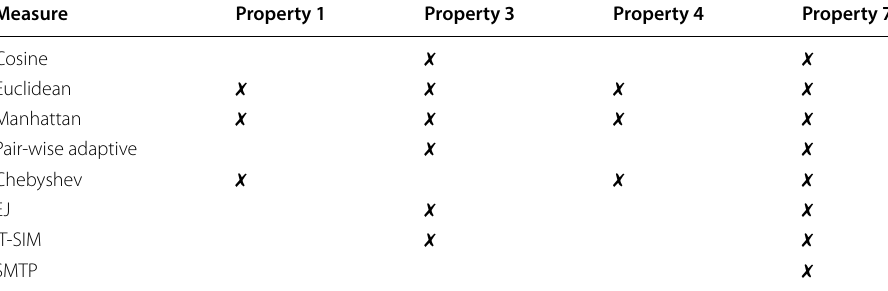
Table 1 Deficiencies of some popular measures according to the preferable properties for a similarity